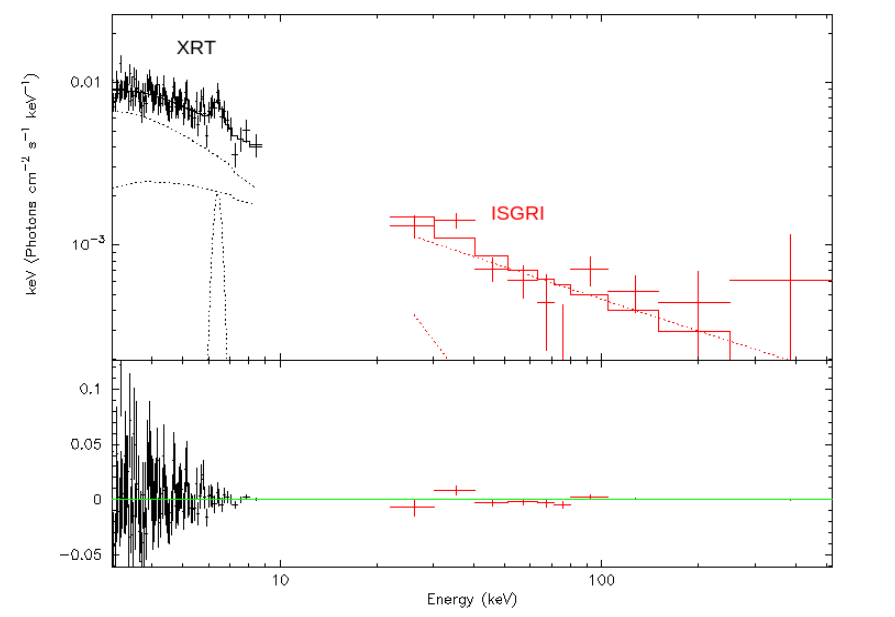
Figure A11. Unfolded SWIFT/XRT and INTEGRAL/ISGRI spectra of 3C 111 during 11th observational period (February 2013) and model. Above: all the spectra are shown by crosses; fitting curves are shown by solid lines; model components are shown by dotted lines; below: data residuals. During this period jet base and nuclear emission components were on the same level; Fe-K α emission line is clearly present.